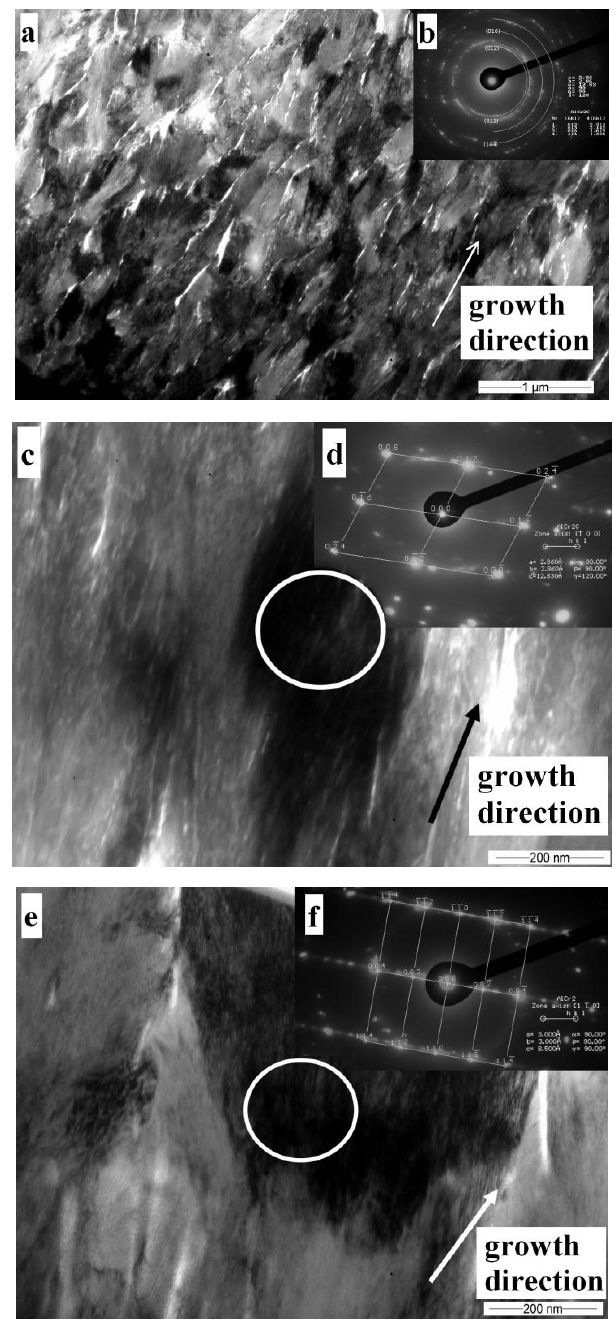
Figure 4. ( a , c , e ) Bright-field images; and ( b , d , f ) calculated SAED patterns of Cr 2 AlC coating deposited at 2.5 kW sputtering power. SAED patterns were taken from the marked areas.